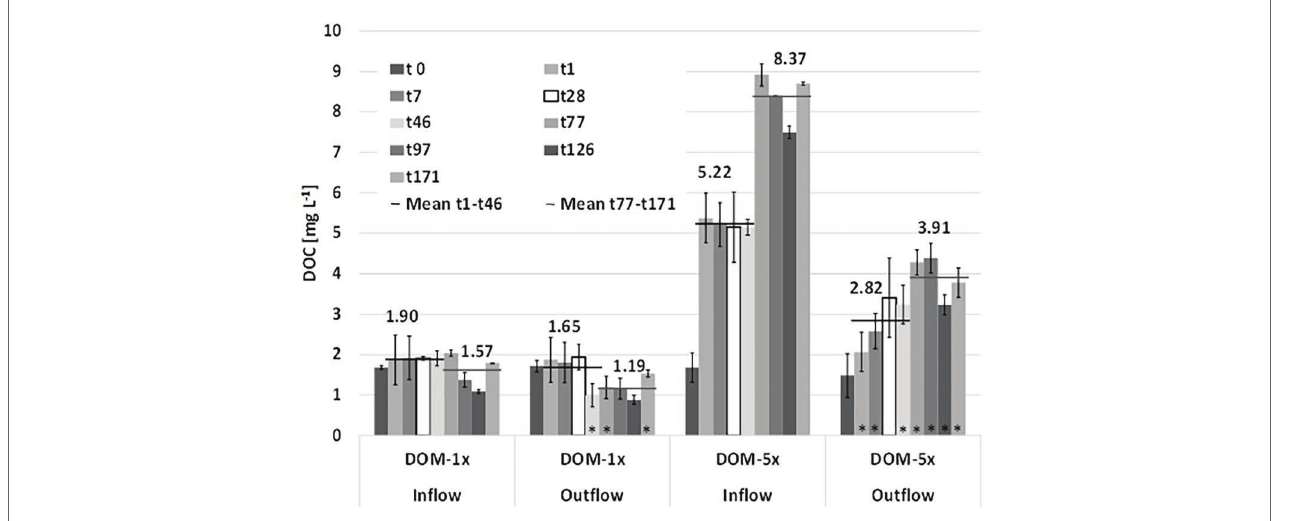
FIGURE 2 | Depletion of dissolved organic carbon (DOC) during passage through the sediments of the two microcosms supplied with DOM-1x and DOM-5x. Data are mean values ± SD. Each of the two microcosm contained a DOM-1x and DOM-5x zone (biological replicates). For the individual sediment zones of each tank, additional technical replicate measurements were